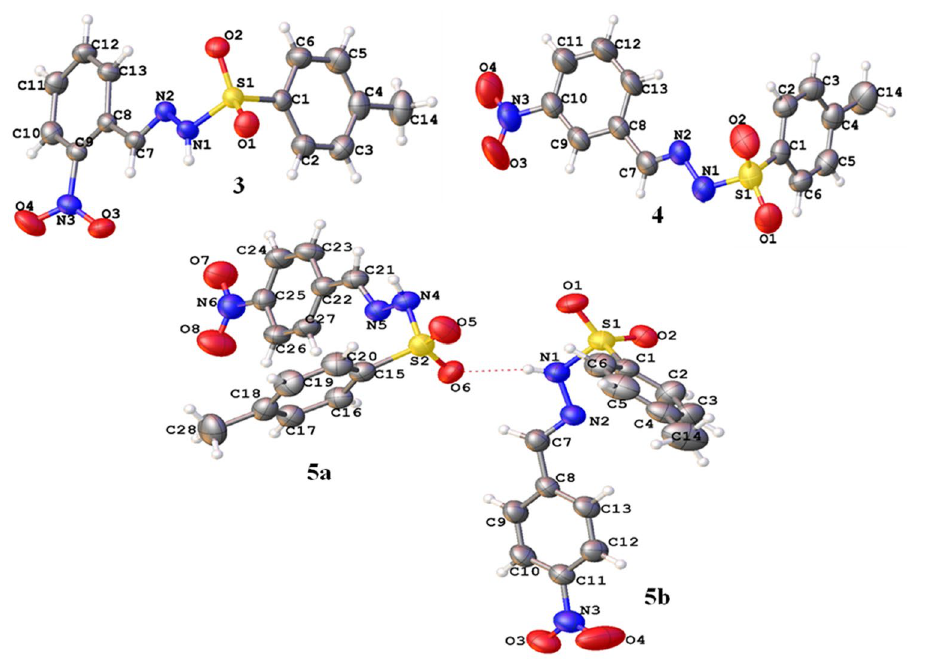
Figure 3. Crystal structure of the MNBBSH